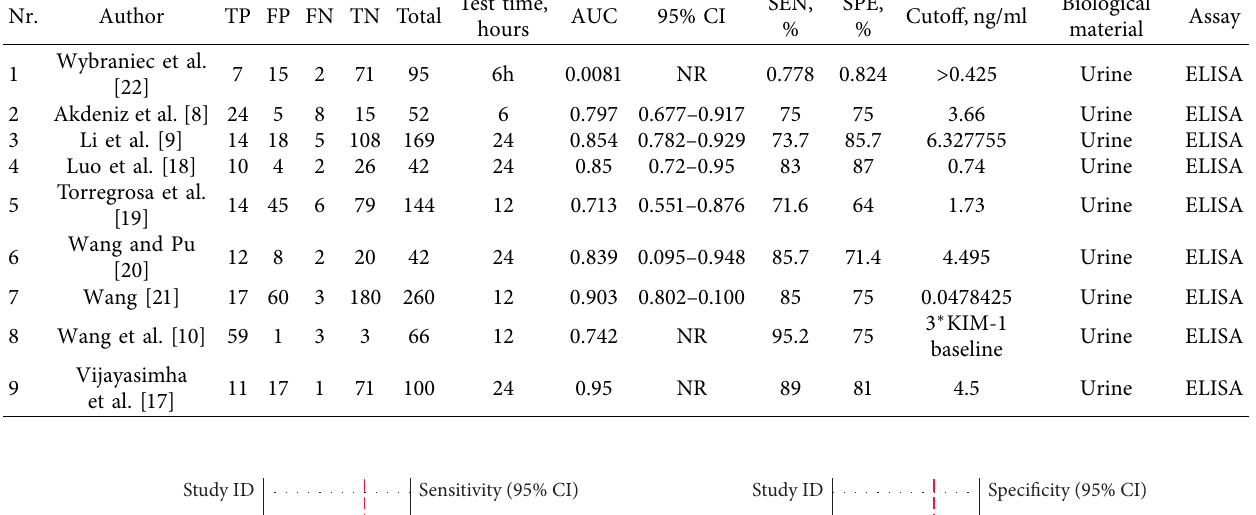
Table 2: Performance of KIM-1 for CIN or CI-AKI diagnosis in the meta-analysis.